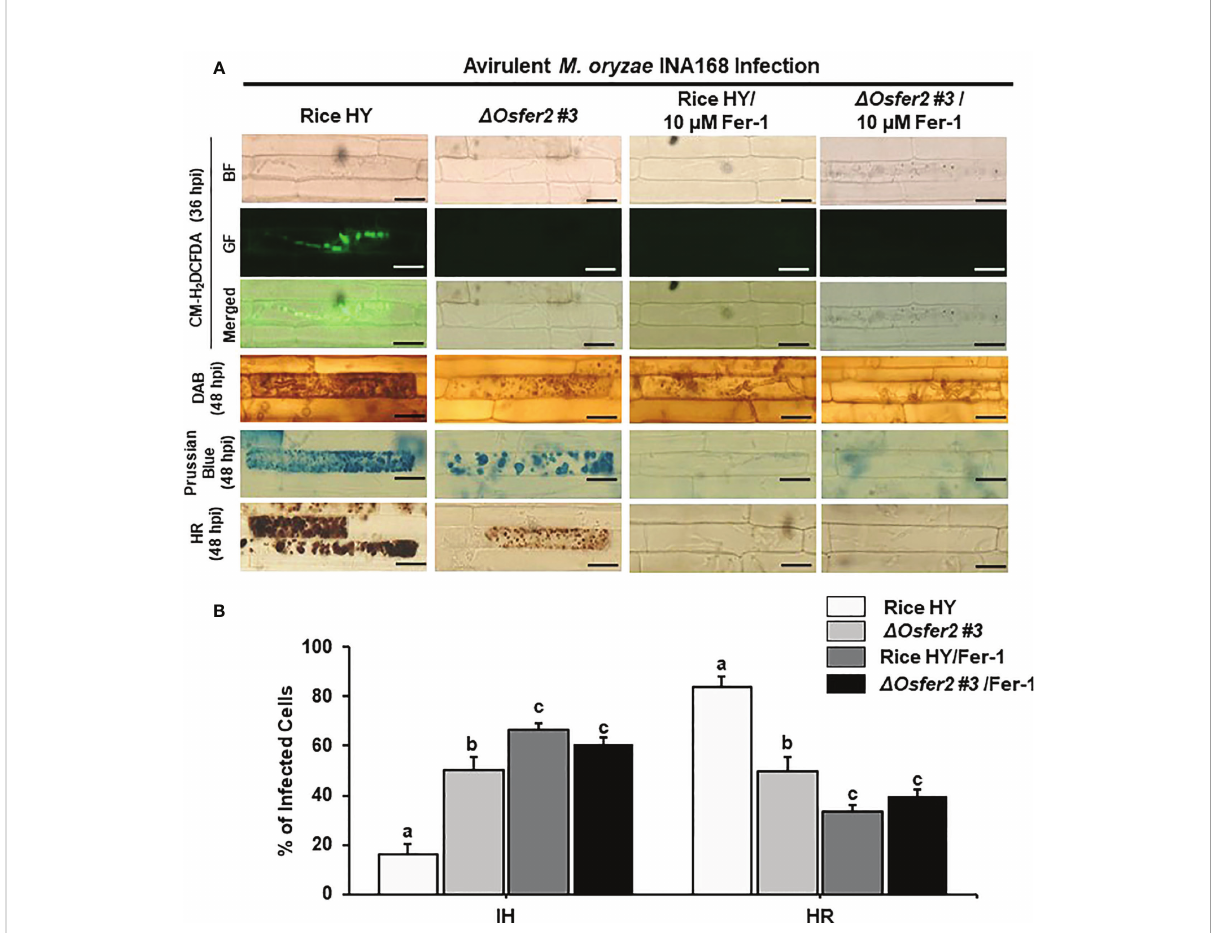
FIGURE 10 Treatment with ferrostatin-1 (Fer-1) inhibits ROS and ferroptotic HR cell death in the rice sheath epidermal layers of rice HY and D Osfer2 knock- out mutants infected with avirulent Magnaporthe oryzae INA168. (A) Microscopic images of HR cell death, DAB, Prussian blue and CM- H 2 DCFDA staining of rice sheath epidermal cells infected with M. oryzae INA168 and treated with 10 µM Fer-1. Scale bar = 20 µm. (B) Quanti fi cation of invasive hyphae (IH) and hypersensitive response cell death (HR) in rice sheath cells infected with M. oryzae INA168 and treated with Fer-1. The rice sheath epidermal layers were incubated in 10 µM Fer-1 in dark condition at 25°C for 24 h after inoculation with M. oryzae conidia (4×10 5 conidia mL − 1 ). The values are means ± SD; n=4 leaf sheaths from different plants. Different letters above the bars indicate signi fi cantly different means ( P <0.05), as analyzed by one-way ANOVA analysis. hpi, hour post-inoculation; HR, hypersensitive response; BF, bright fi eld; GF, green fl